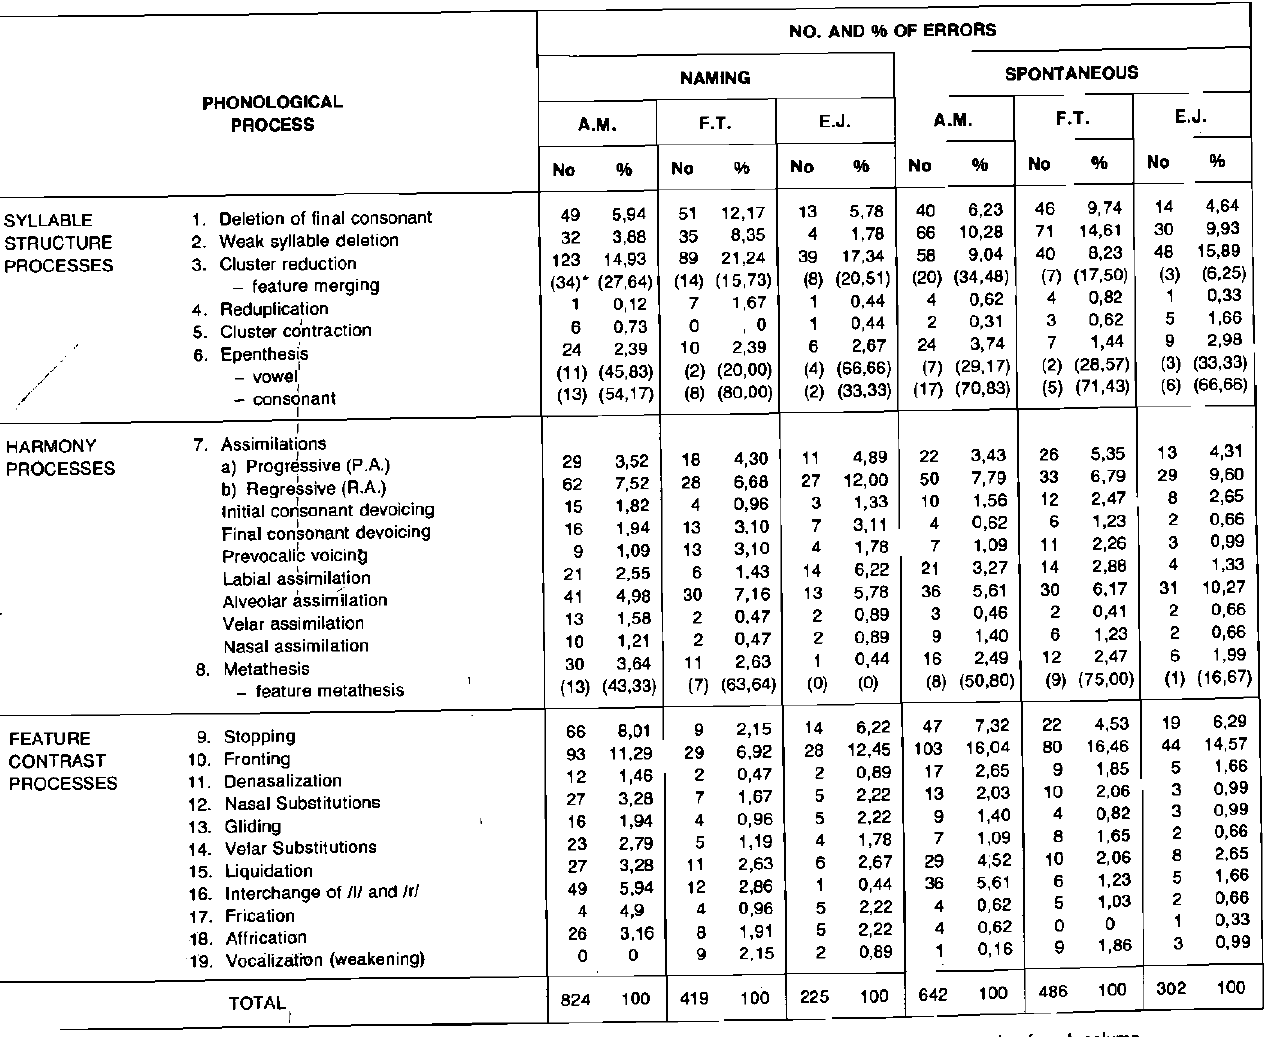
Table 3 A distribution of errors on CVC and CCVC words according to phonological processes